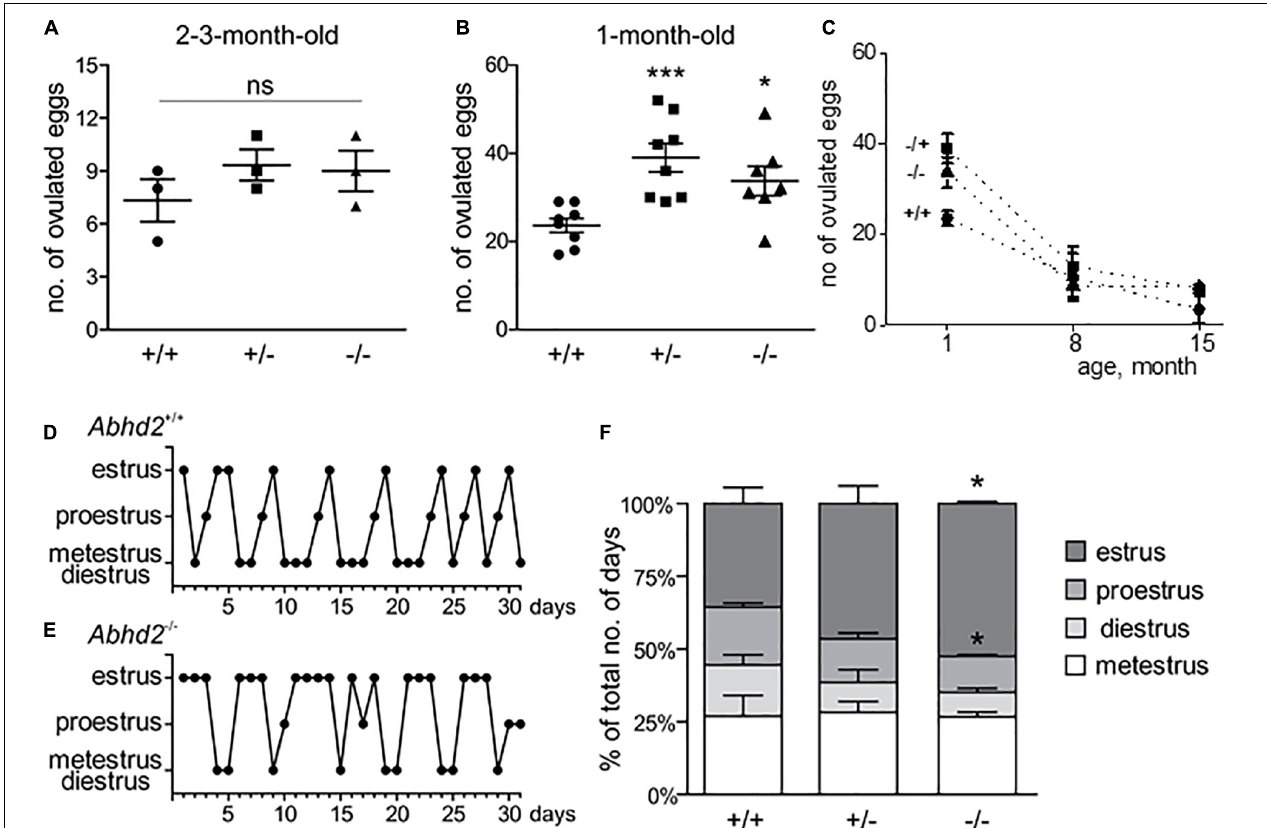
FIGURE 3 | Abhd2 − / − female ovulation and estrous cycle. (A) Spontaneous ovulation gave rise to similar numbers of eggs for all genotypes ( n = 3 for each genotype). (B) Abhd2 ablation caused significantly increased numbers of ovulated eggs after induction of superovulation, in both 1-month-old Abhd2 + / − ( n = 8) and Abhd2 − / − ( n = 7) females compared with Abhd2 + / + mice ( n = 8). Statistical significance was calculated using the unpaired t -test, and the significance of changes is indicated as follows: * p ≤ 0.05; *** p ≤ 0.001. (C) Age-dependent decline in the number of eggs obtained after superovulation of 1-month-old females [data from panel (B) ], as well as 7- to 8-month-old ( Abhd2 + / + n = 5, Abhd2 + / − n = 7, and Abhd2 − / − n = 6) and 15-month-old females ( n = 3 per genotype). Representative graphs of the estrous cycle of a (D) Abhd2 + / + and (E) Abhd2 − / − female mouse where the Abhd2 KO female shows prolonged stages in estrus although displaying cyclical changes throughout the month. (F) The combined measurements of three mice of each genotype also showed a significantly altered distribution of days in the different estrous stages, in particular, the increased percentage of days in estrus and decreased percentage of days in proestrus of Abhd2 − / − females compared with Abhd2 + / + mice ( n = 3 for each genotype).